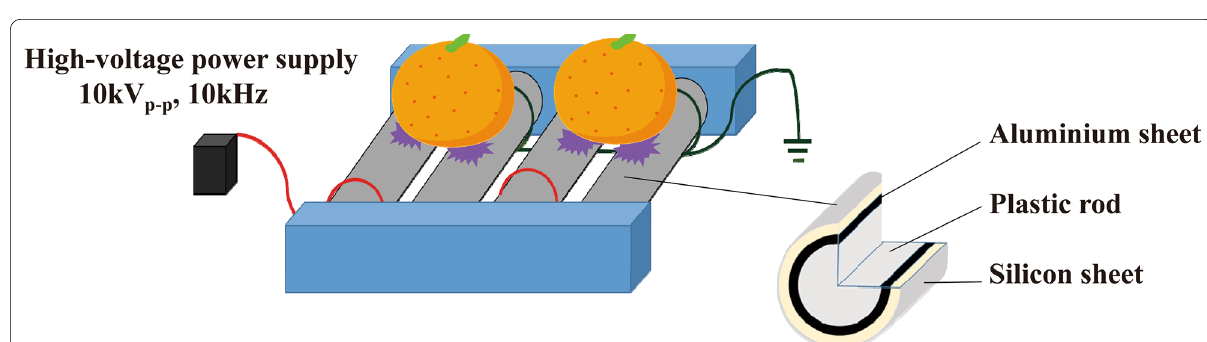
Fig. 5 Viable cell number of P. venetum spotted onto the pericarp of citrus fruits following APDBD treatment. The viable cell number is expressed as CFU per ml. CFU/ml of P. venetum present on the contaminated pericarps of a ‘Kiyomi’ ( C. unshiu natsudaidai ) at each individual APDBD treatment time (0, 1, or 2 min) are shown. Differences where p < 0.05(*) and p < 0.01(**) versus control (0 min) were considered significant when verified by the non-repeated measured ANOVA followed by the Bonferroni correction